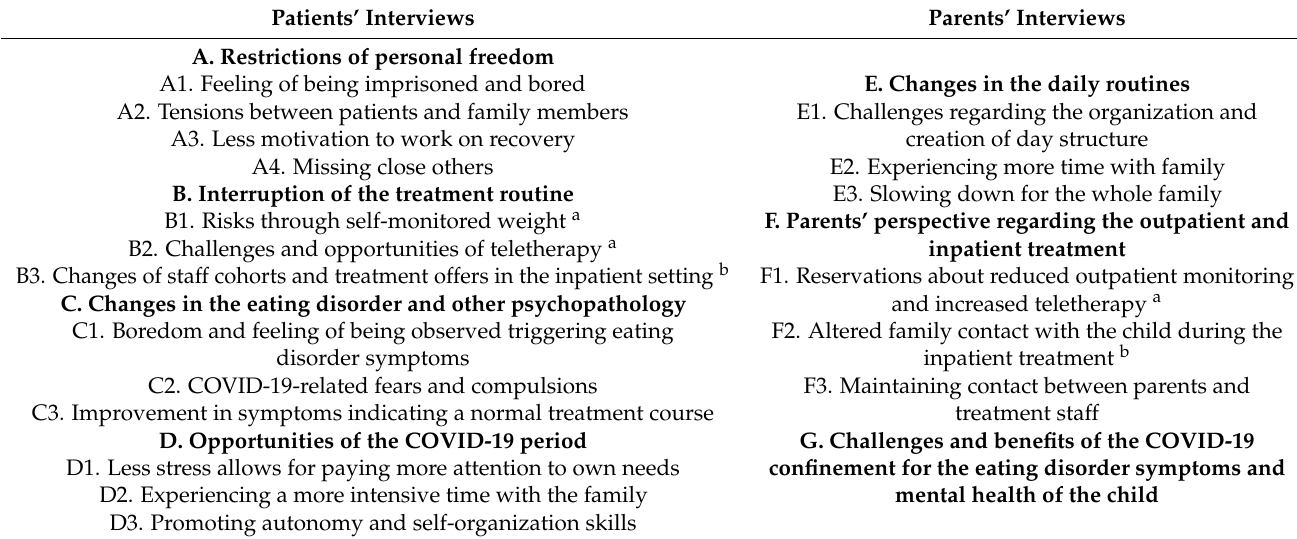
Table 1. Summary of the main and subthemes identified from the